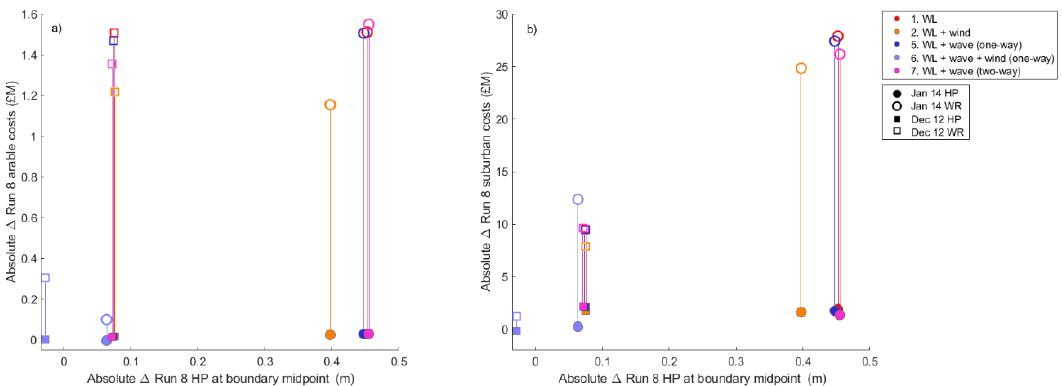
Figure 9. Absolute difference in HP at the boundary midpoint (shown in Figure 1a) against absolute difference in ( a ) arable land costs and ( b ) suburban land cost for runs 1,2,5,6 and 7 compared to baseline run 8 for each WR or HP simulation, depending on the approach used to force the model boundary.